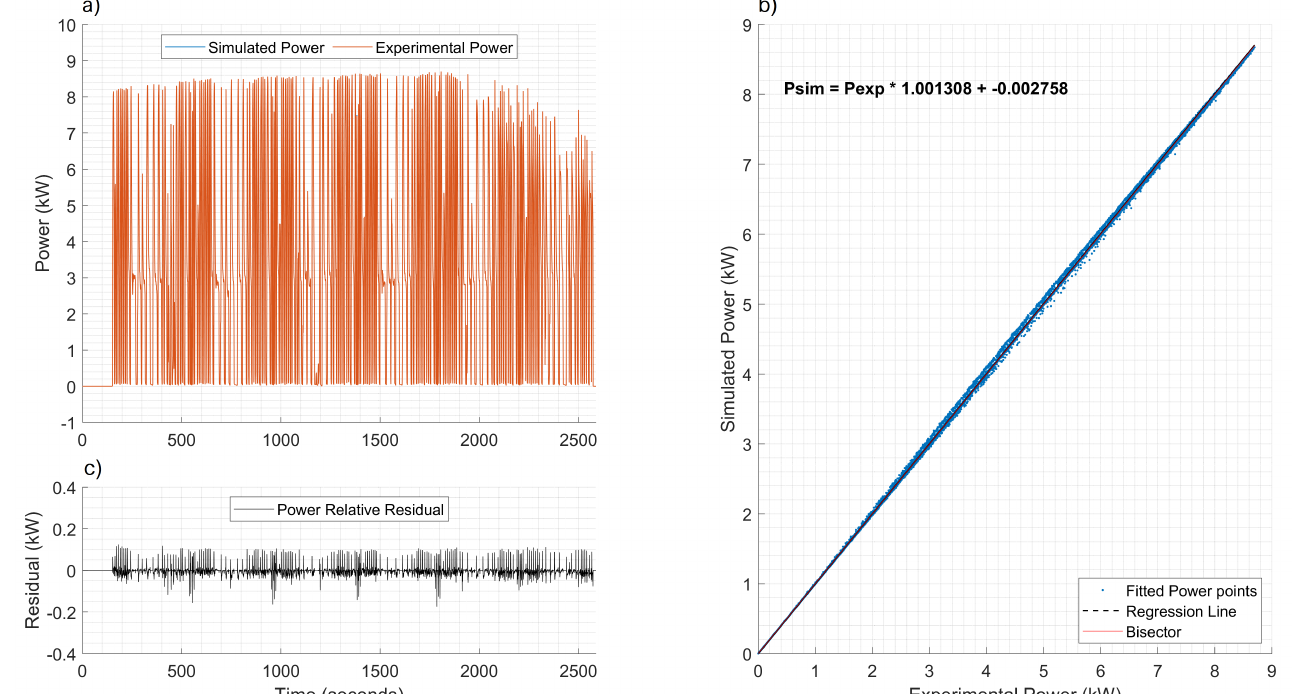
Figure 13. Test #1.1: Regression process results for estimation of model power. ( a ) The simulated and experimental power on real driving mission and ( c ) residual error of estimation. ( b ) Regression process results in terms of fitting equation and bisector